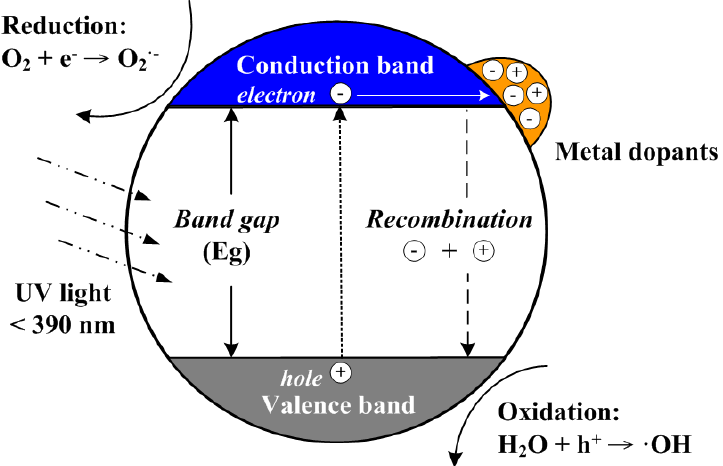
Figure 2. Schematic of metal-TiO 2 photocatalytic mechanism.